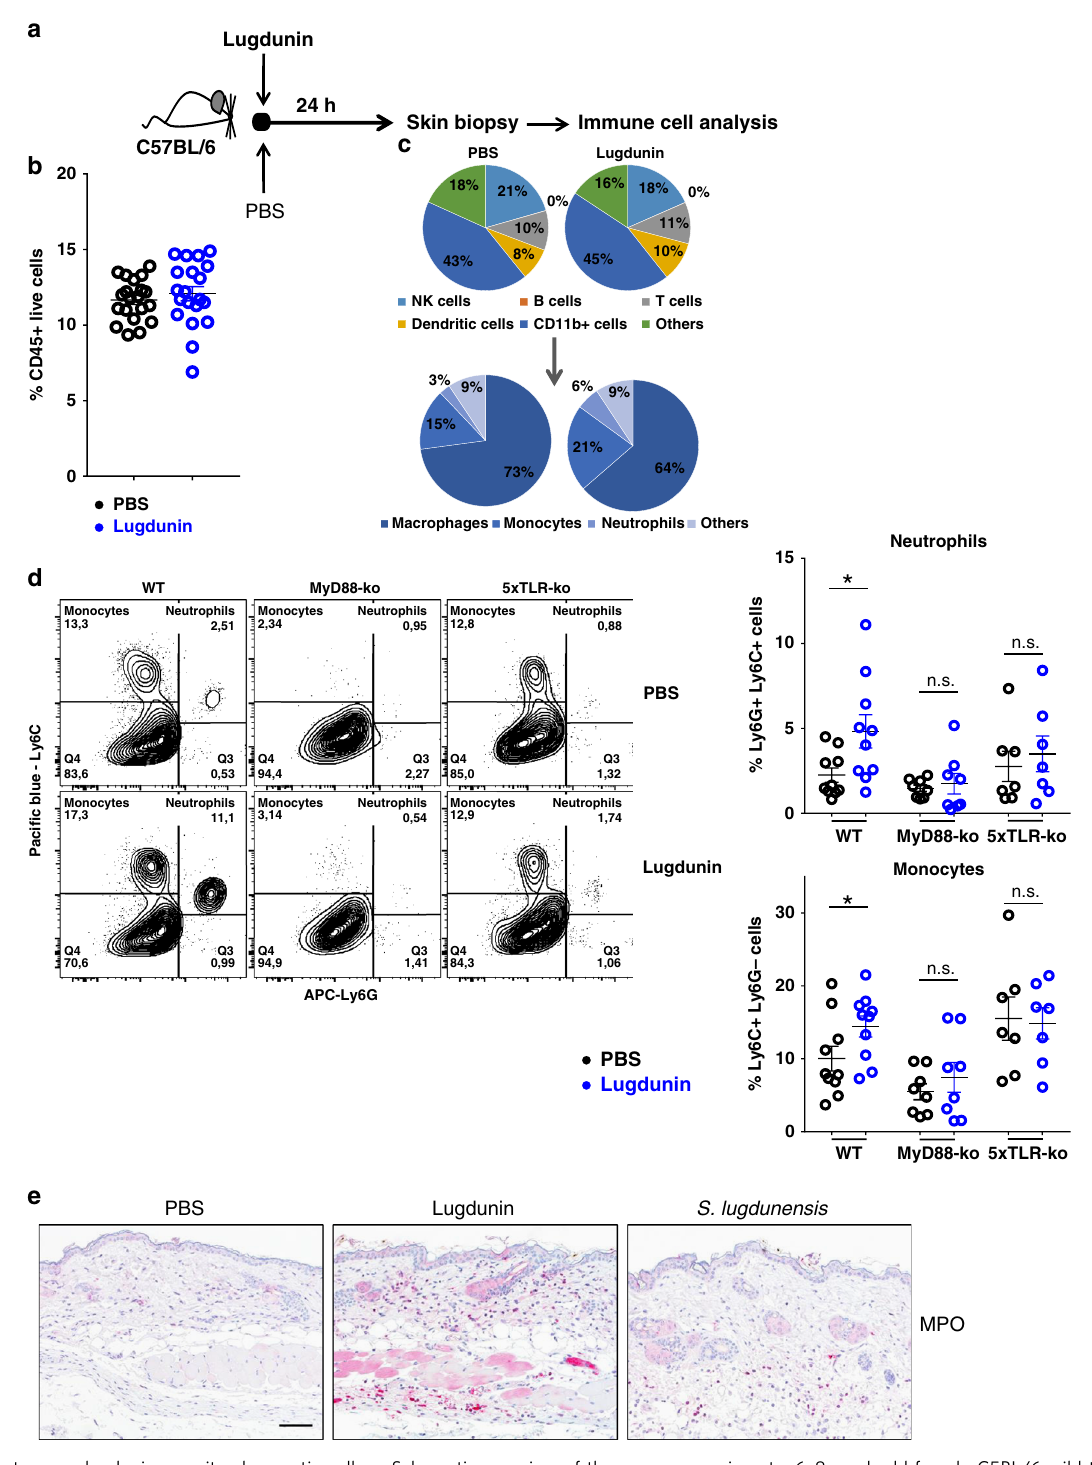
Fig. 3 Epicutaneous lugdunin recruits phagocytic cells. a Schematic overview of the mouse experiments: 6 – 8-week-old female C5BL/6 wild-type (WT), MyD88-ko, or 5xTLR-ko mice were epicutaneously treated with 1.5 µ g lugdunin or phosphate-buffered saline (PBS) as a control. After 24 h, mice were euthanized, immune cells were isolated from treated skin areas, and immune cell composition was analyzed by fl ow cytometry. b Shown is the mean percentage of CD45 + live cells in mouse skin of 10 C57BL/6 WT mice ± s.e.m. One mouse is represented as two dots analyzed by two different stainings. c Pie charts show the mean percentage of the different immune cell subsets in the skin of 10 WT mice after 24 h of PBS or lugdunin treatment. d Shown are representative fl ow cytometry data (left panel) and the mean percentage of neutrophils (Ly6C + Ly6G + ) and monocytes (Ly6C + Ly6G − ) pregated on CD11b + CD45 + live cells (see Supplementary Fig. 3a, f for the gating strategy) in mouse skin ± s.e.m. One dot represents one mouse. * P < 0.05. e Representative myeloperoxidase (MPO)-stained paraf fi n-embedded mouse skin sections. Scale bar, 100 µ M. Source data are provided as a Source Data fi